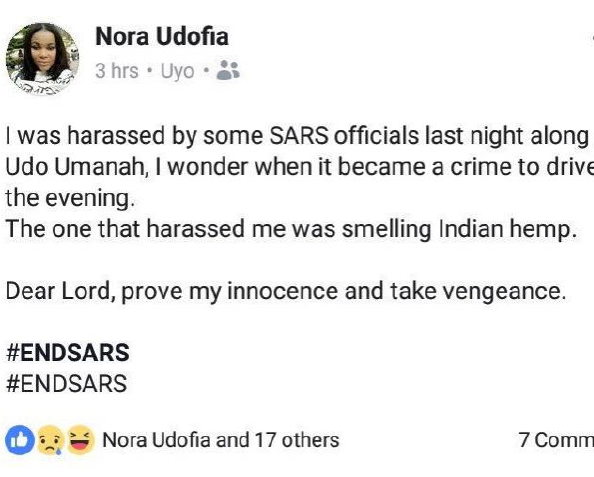
Figure 2: Retweet by AlgoRidm @ridbay; Source: Udofia,